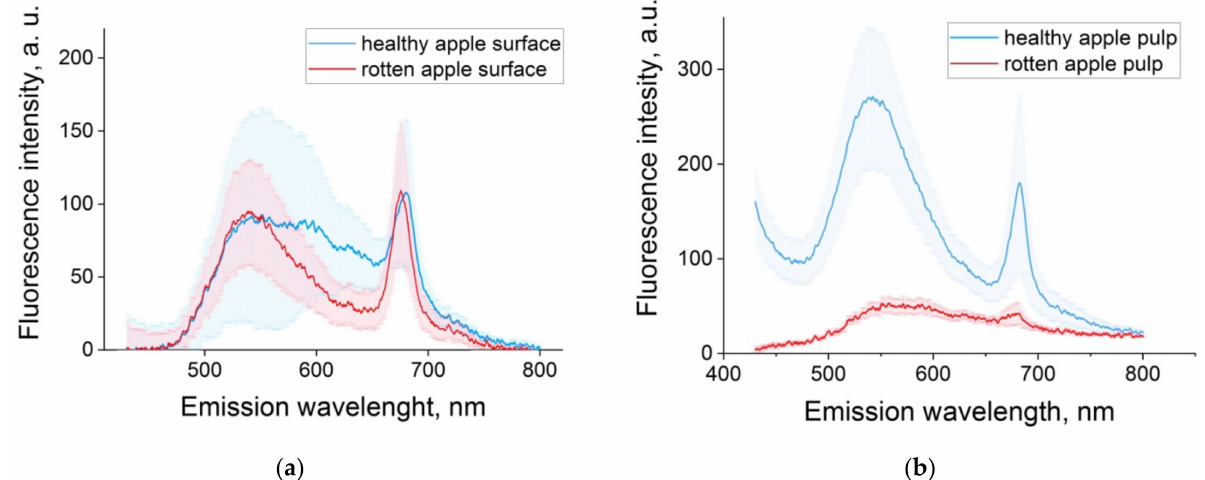
Figure 5. ( a ) Continuous-wave fluorescence spectra of healthy (blue) and rotten (red) surface of apple; ( b ) continuous-wave fluorescence spectra of healthy (blue) and rotten (red) pulp of apple. In Figure 5, the spectral differences between healthy and rot-affected fruits are